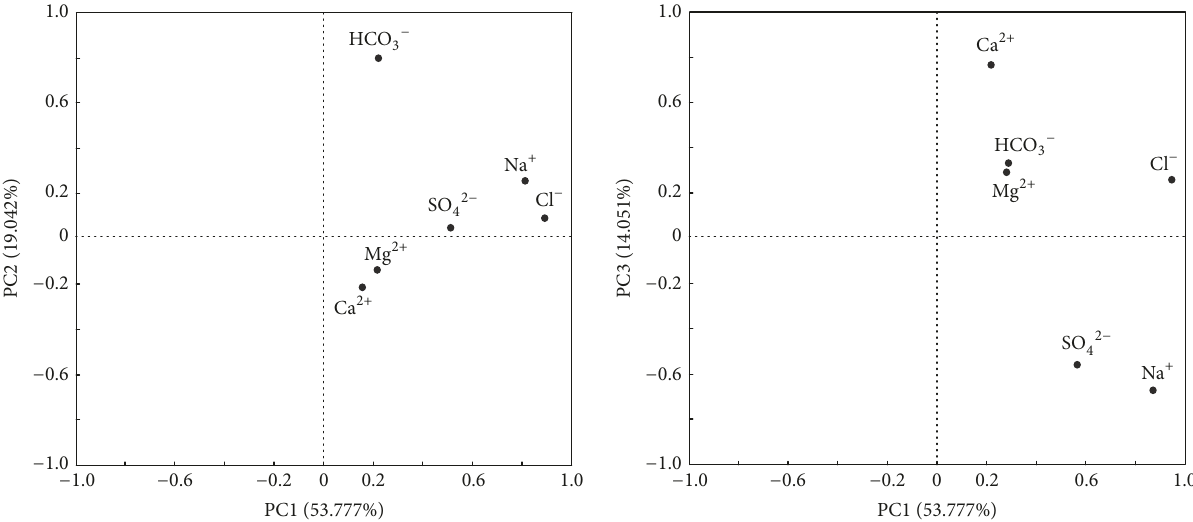
Figure 8: Plot of loadings for the three components with Varimax normalized rotation.